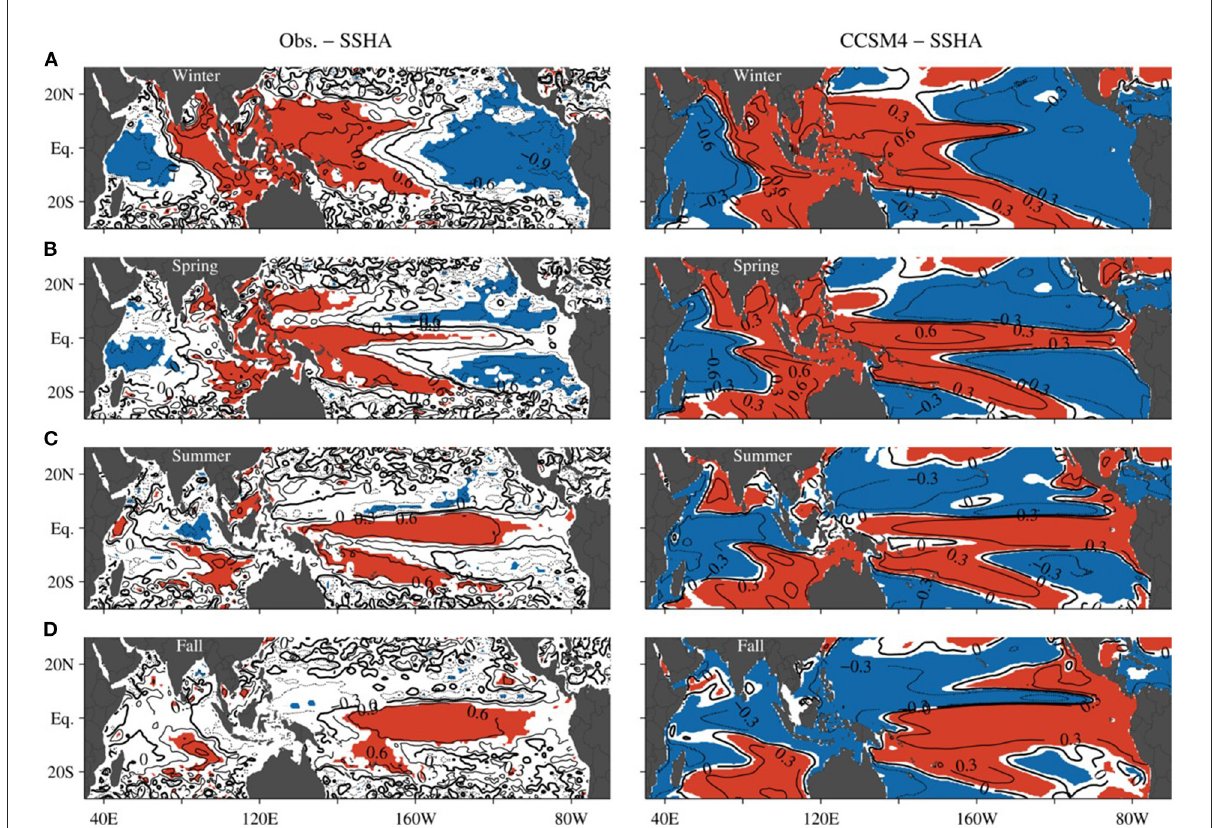
FIGURE5 Comparison of observed (left column) and simulated (right column) lag correlations between the SSHA in STIO in fall and the tropical Indo-Pacific SSHA in the following four seasons during the positive phases of the decadal variability (from 1993 to 2009 in the observation). (A) Winter (December to February). (B) Spring (March to May). (C) Summer (June to August). (D) Autumn (September to November). The contour interval is 0.3. Red and blue shades indicate 95% confidence level of positive and negative correlation, respectively. The model correlations are nearly everywhere above the 95% significance level due to the long time